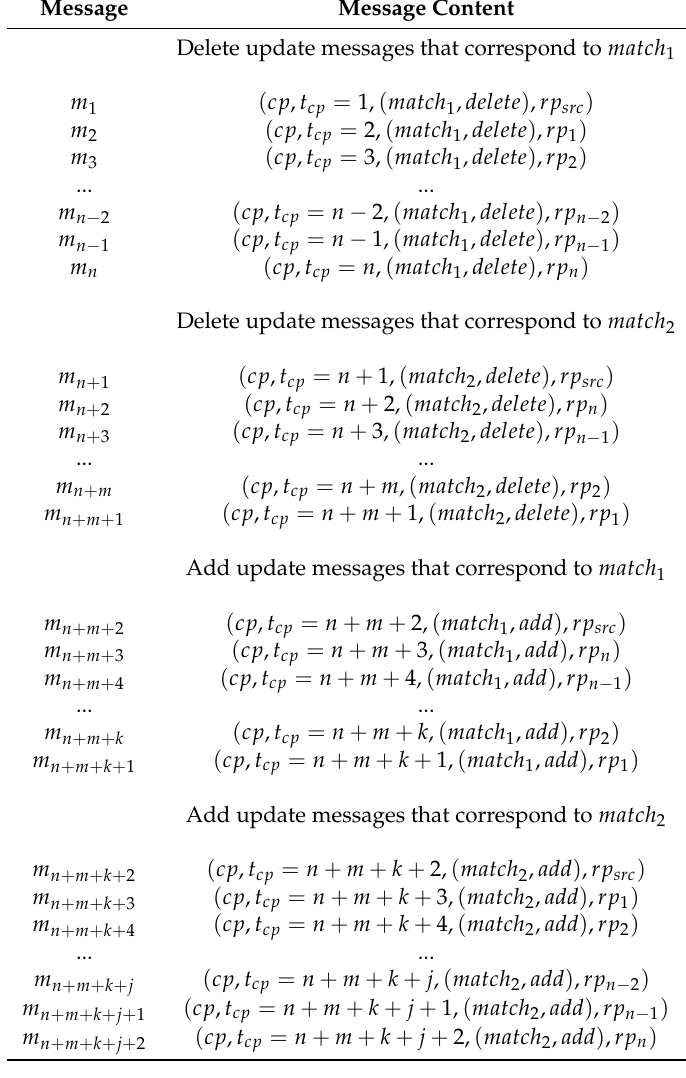
Table 1. Update messages calculated for updating P rp that correspond to match 1 and match 2